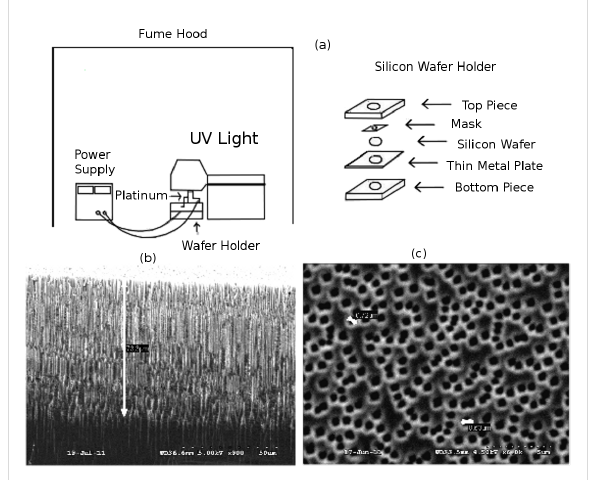
Figure 10: (a) Schematic view of apparatus used to generate the micro/nanoporous structure in n-type silicon. (b) top and (c) side view of the pores. Reproduced with permission from [7]. Copyright 2012 Wiley-VCH.